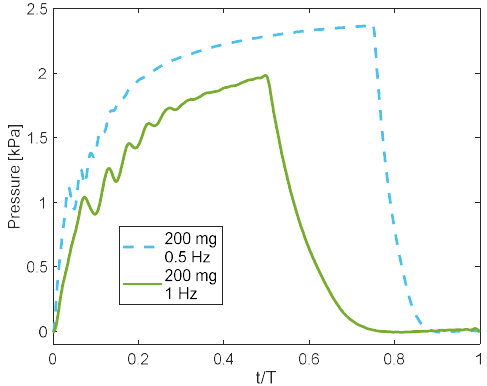
Figure 10. Pressure results during two shapes of pulses for the amount of 200 mg of particles.